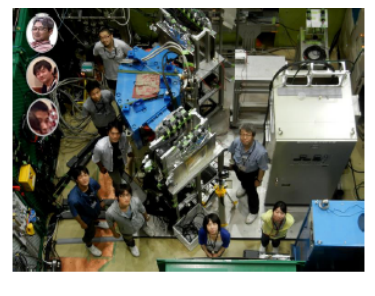
Figure 5: The magnet PAC- MAN which will be used for the spectrometer.